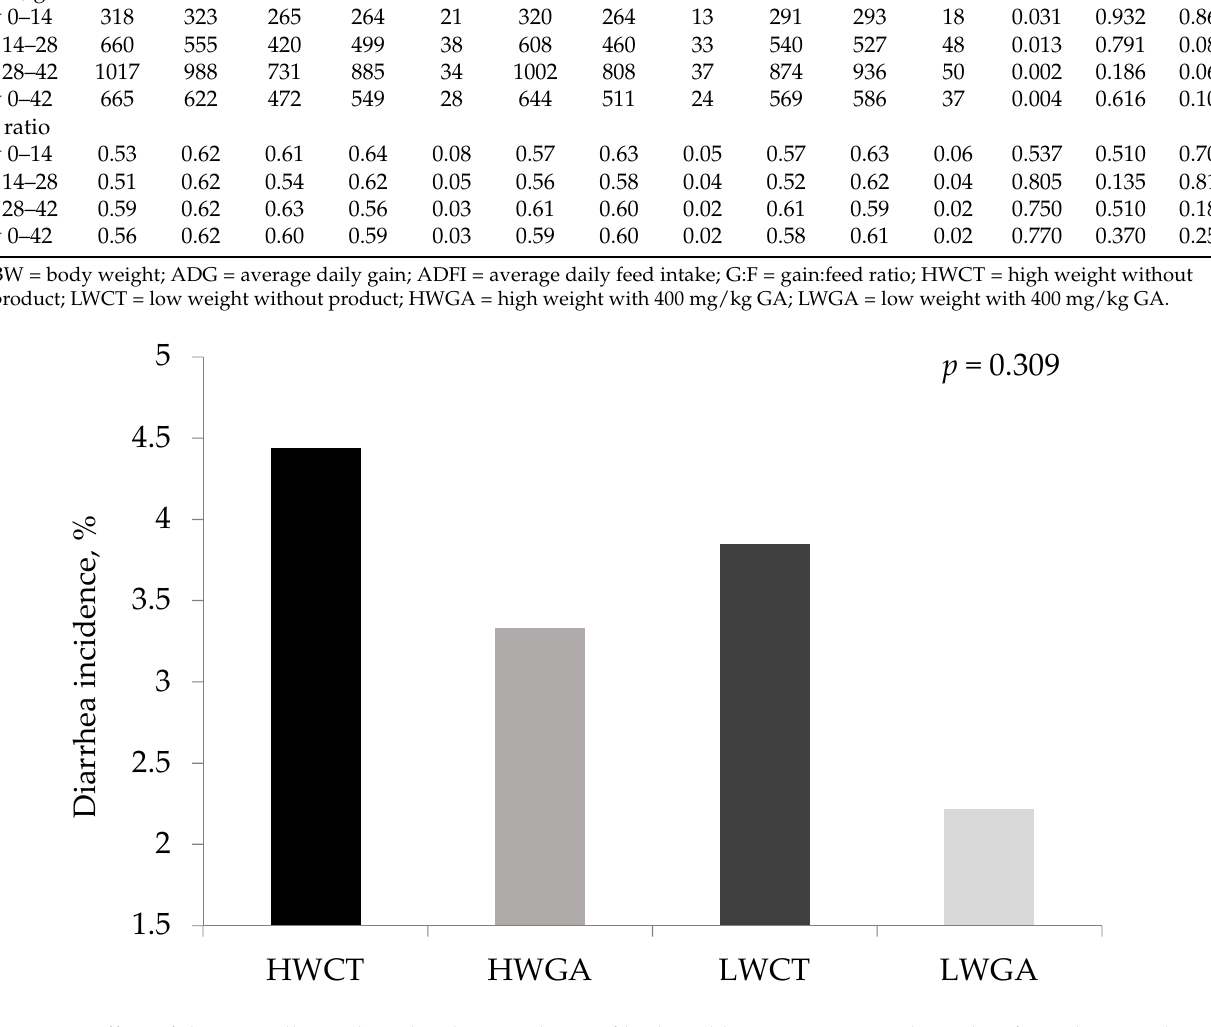
Figure 1. Effect of dietary gallic acid on diarrhea incidence of high and low weaning weight piglets from day 1 to day 14 post weaning.